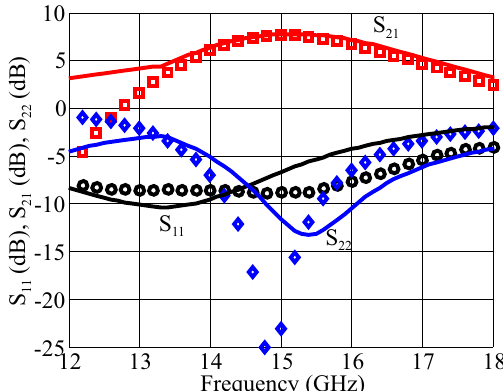
Figure 11. Scattering parameters in the band 12–18 GHz for the 15 GHz combined amplifier. Simulations: solid lines; measurements: symbols. S 11 : black circles, S 21 : red squares, S 22 : blue diamonds.